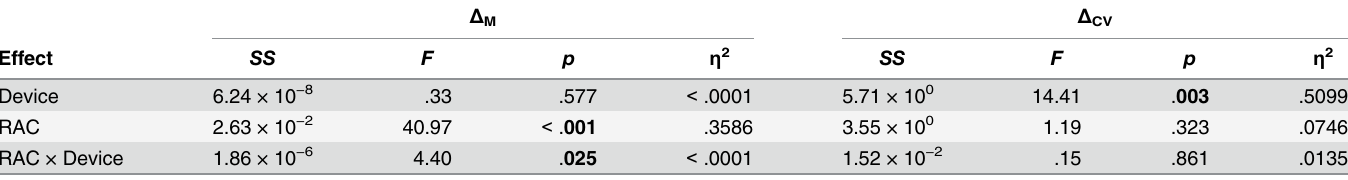
Table 9. Statistics associated with the RAC × Device ANOVA for step time outcome measures in HE subjects.